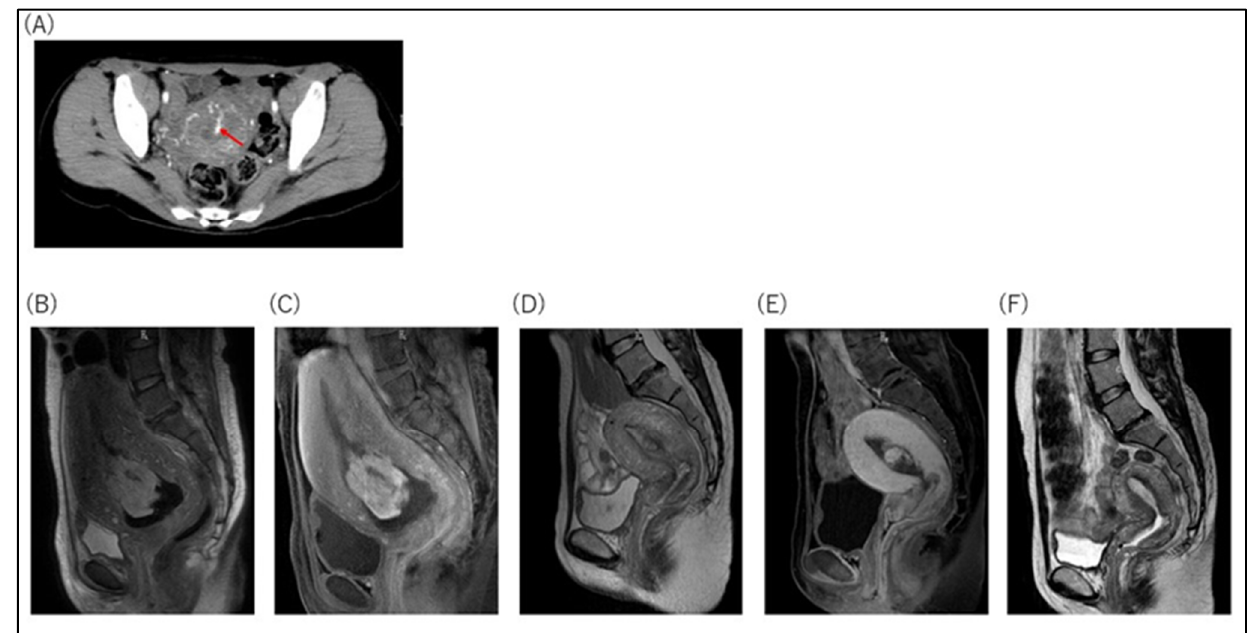
Figure 3. Representative images of RPOC cases with conservative management. ( A ) Case 23: Contrast-enhanced CT showed strongly contrast-enhanced RPOC in the arterial phase (postpartum day 10). Arrow shows RPOC. ( B – F ) Case 37: Serial changes in contrast-enhanced MRI during conservative management. ( B ) Sagittal T2WI showed an RPOC in the uterus. The RPOC size was 72 × 42 × 49 mm (postpartum day 3). ( C ) Sagittal contrast T1WI demonstrated strongly contrasted RPOC (postpartum day 3). ( D ) Sagittal T2WI showed RPOC in the uterus, whose size became smaller. The RPOC size was 22 × 17 × 15 mm (postpartum day 22). ( E ) Sagittal contrast T1WI still demonstrated strongly contrasted RPOC (postpartum day 22). ( F ) MRI did not detect RPOC (postpartum day 64). Ultrasound showed RPOC of 8 mm on postpartum day 87. On postpartum day 102, hysteroscopy